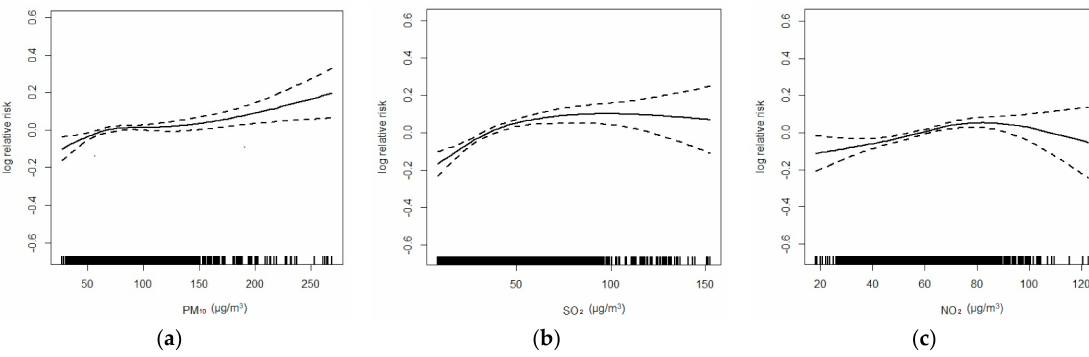
Figure 1. Exposure-response curves for the associations of PM 10 ( a ); SO 2 ( b ) and NO 2 ( c ) with outpatient visits for eczema (lag 06).